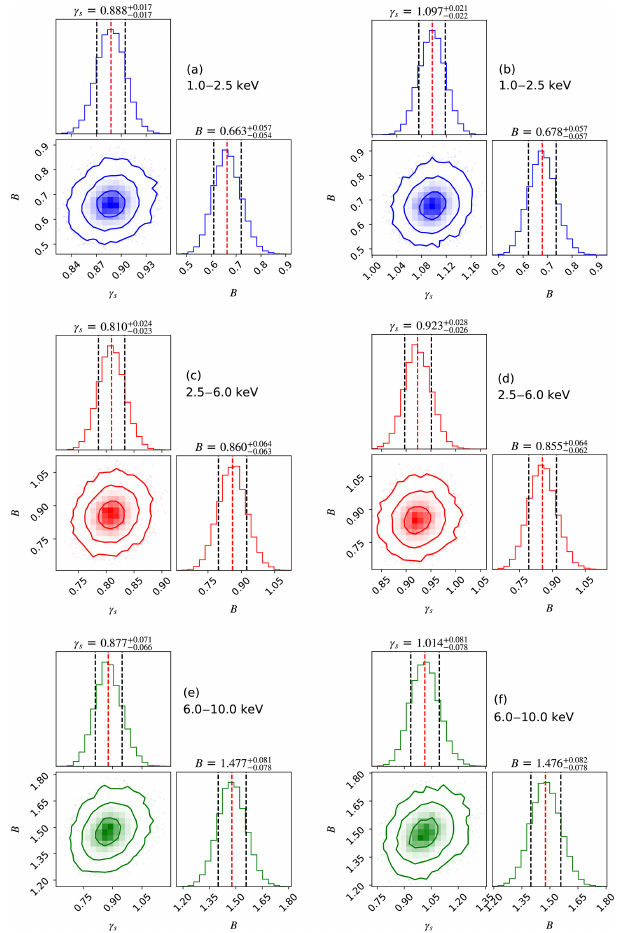
Figure 10. Corner plot showing the one- and two-dimensional pro- jections of the posterior probability distributions for the two free pa- rameters. On the 2D plots, blue, red, and green contours represent 1- , 2-, and 3 σ confidence intervals. The dashed black lines in each of the 1D histograms represent the quantiles 0.16 and 0.84 of the poste- rior probability distribution, with the central dashed red line indicat- ing the median value. The median ± the 68% confidence interval is shown above each histogram. Panels (a) and (b) represent posterior probability distributions based on NRLMSISE-00 and NRLMSIS 2.0, respectively, by fitting the light curves in 1.0–2.5keV. Panel (c) and (d) represent posterior probability distributions based on NRLMSISE-00 and NRLMSIS 2.0, respectively, by fitting the light curves in 2.5–6.0keV. Panel (e) and (f) represent posterior prob- ability distributions based on NRLMSISE-00 and NRLMSIS 2.0, respectively, by fitting the light curves in